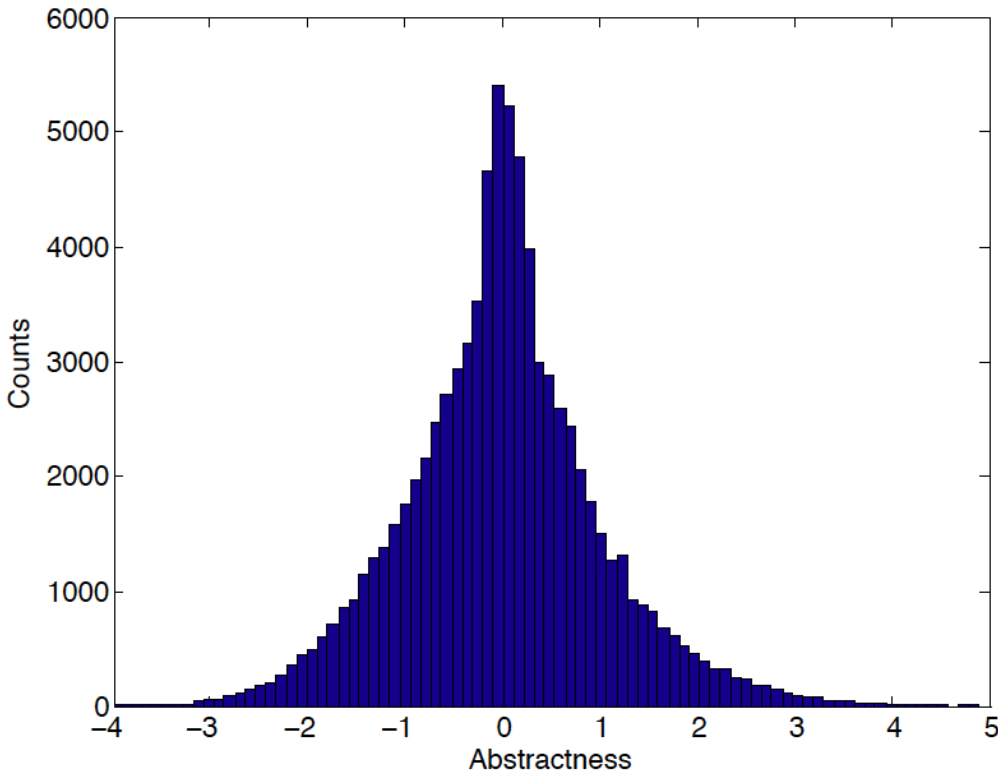
Figure 4. Histogram distribution of sense-based noun